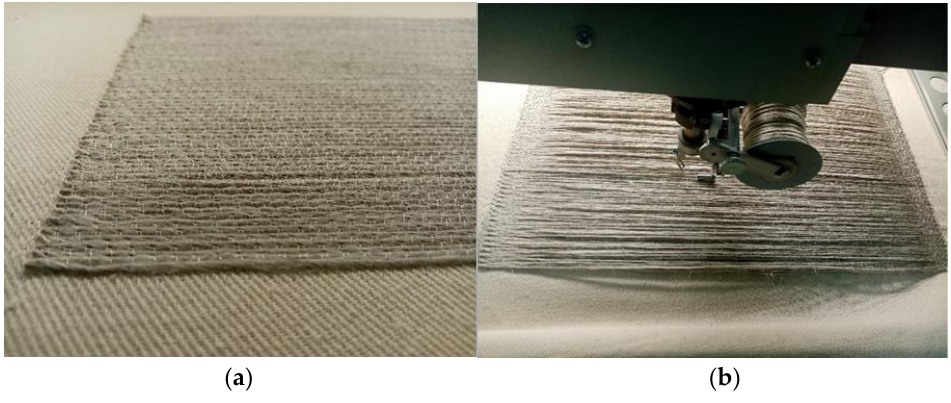
Figure 2. ( a ): technical embroidery; ( b ): UD fabric (own